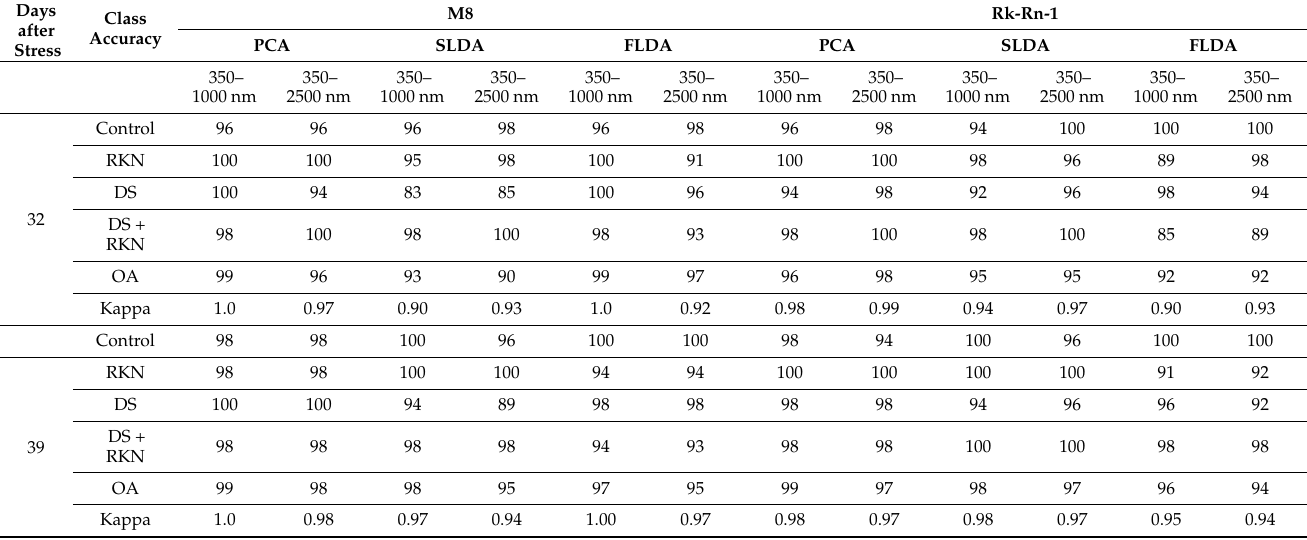
Table 2. Classification accuracies for a four-class problem (control, drought stress (DS), root–knot nematode (RKN) stress, and DS + RKN stress combination) using leaf spectral reflectance information between 350–1000 nm and 350–2500 nm measured of two cotton genotypes (M8 and Rk-Rn-1) at 32, 39, 46, 53, and 72 days after stress treatment in